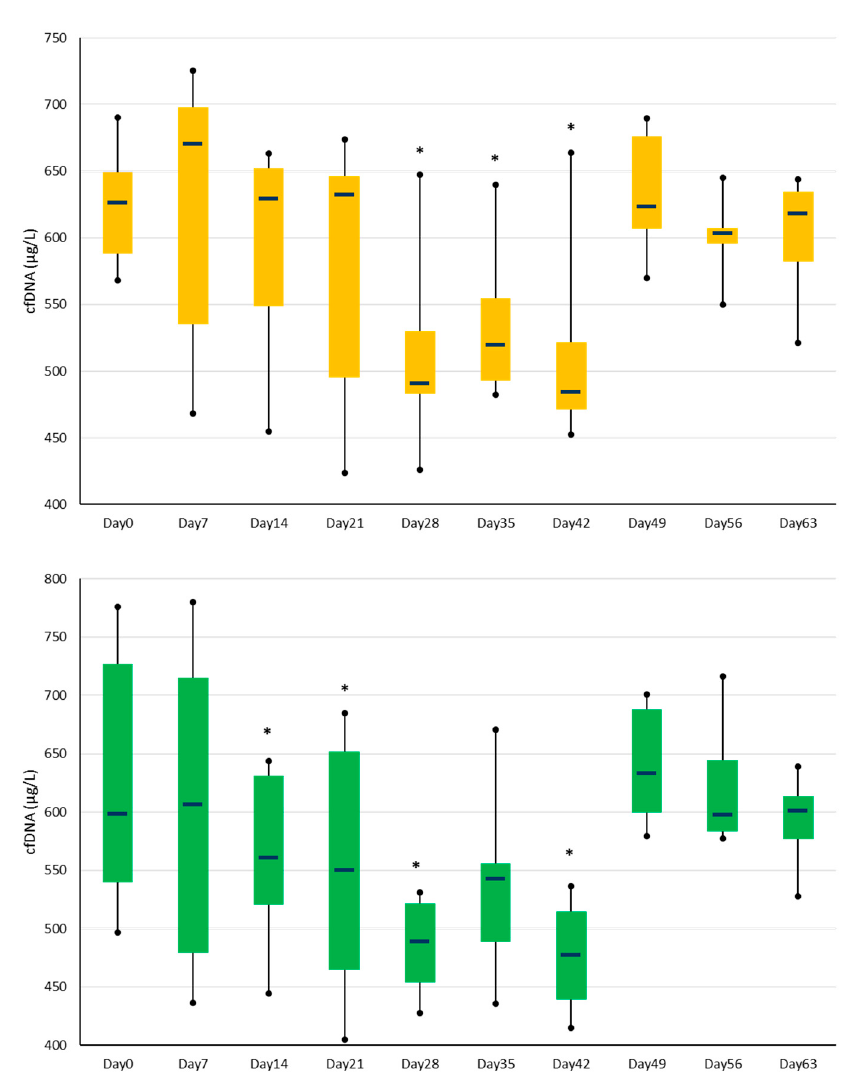
Figure 2. Plasma cell-free DNA concentrations in the OA (top graph) and sham (bottom chart) groups over time. The * indicates significant differences ( p < 0.05) from the respective group Day 0 values. The bars represent the interquartile range, and the horizontal lines within the bars are the median values. Whiskers indicate the minimum and maximum values.